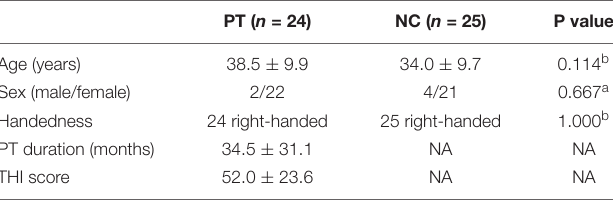
TABLE 1 | Demographic data for PT patients and NCs.